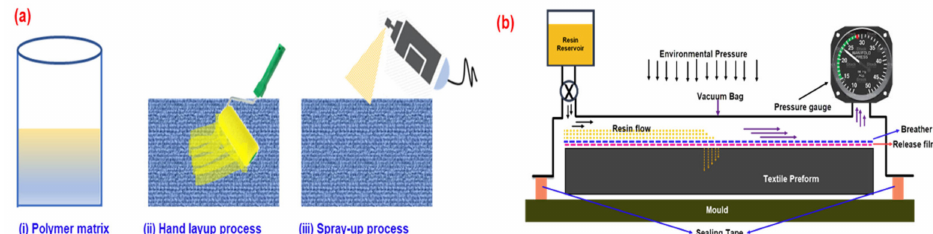
Figure 5. Composite moulding techniques. ( a ) Open moulding techniques: (i) polymer matrix; (ii) hand layup process; (iii) spray-up process (Reprinted with permission from [93]; Copyright 2018 Informa UK Limited). ( b ) Closed moulding technique: vacuum-assisted resin transfer moulding (VaRTM) (Reprinted with permission from [89]; Copyright 2012